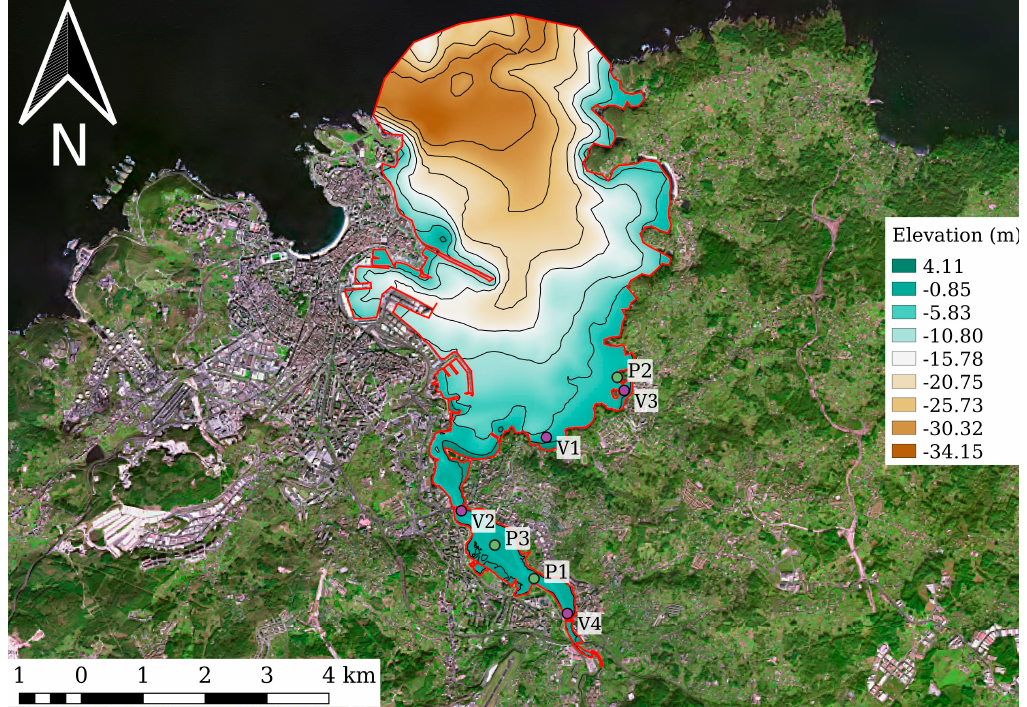
Figure 6. Bathymetry of the estuary of A Coruña (NW, Spain). The sewage spills are located at V1, V2, V3 and V4. The control points are placed at P1, P2 and P3.